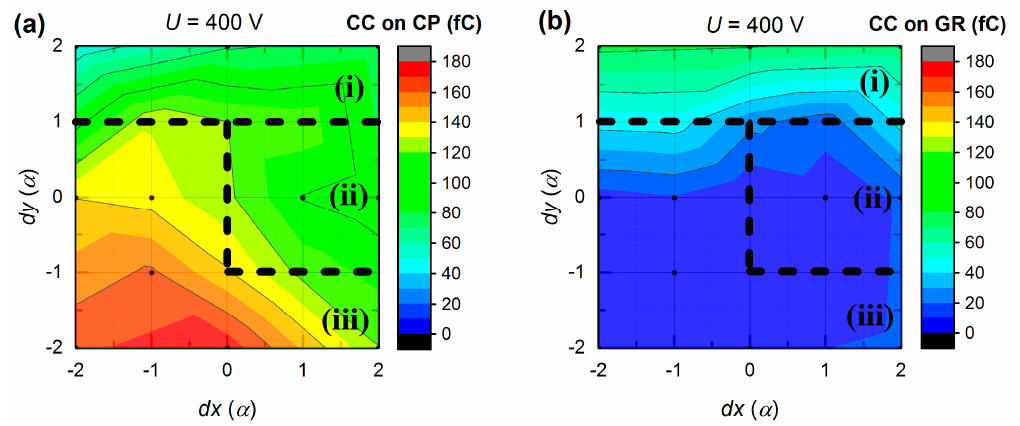
Figure 11. Dependence of collected charge (CC) on ( a ) CP and ( b ) GR on illumination position at 400 V bias ( α = 0.85 mm).